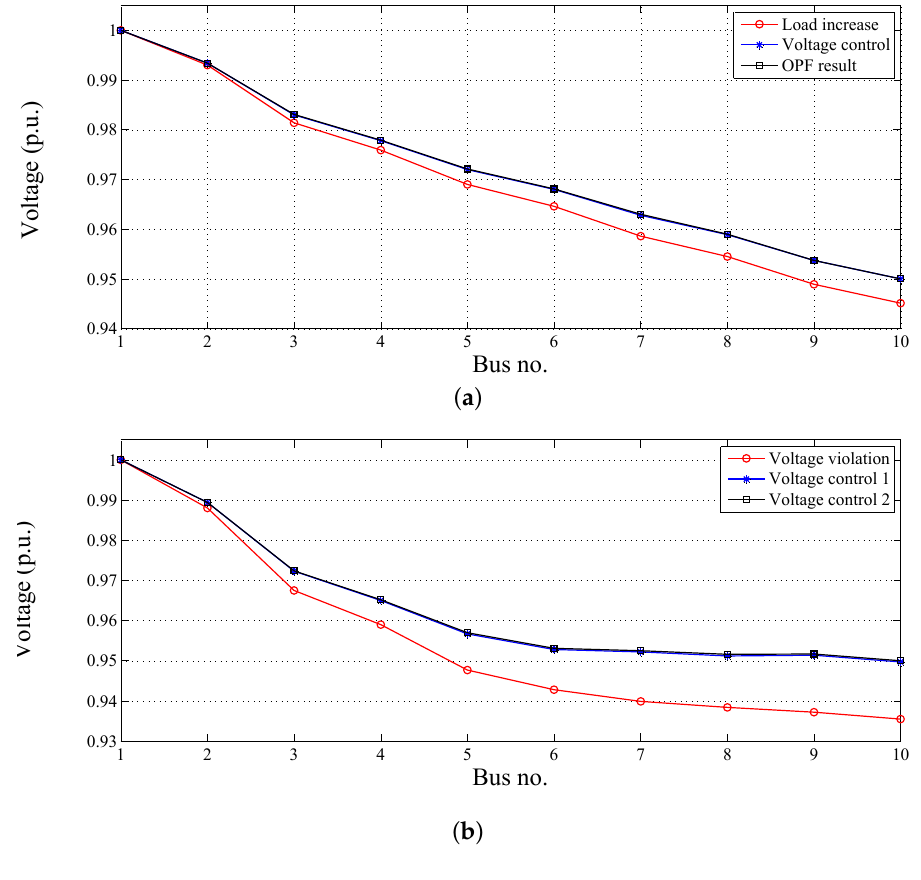
Figure 12. Voltage profiles: ( a ) For Case 1; and ( b ) For Case 2.